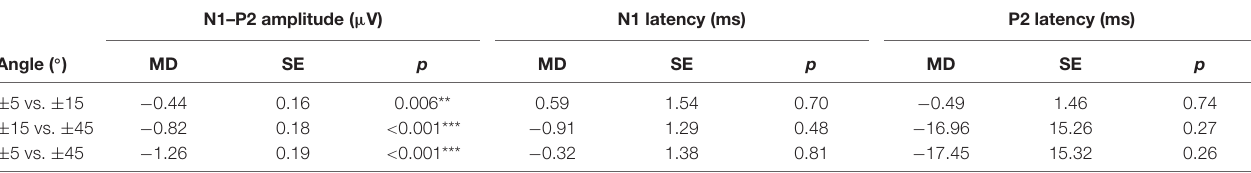
TABLE 2 | Comparisons of onset-CAEP between different test angles.